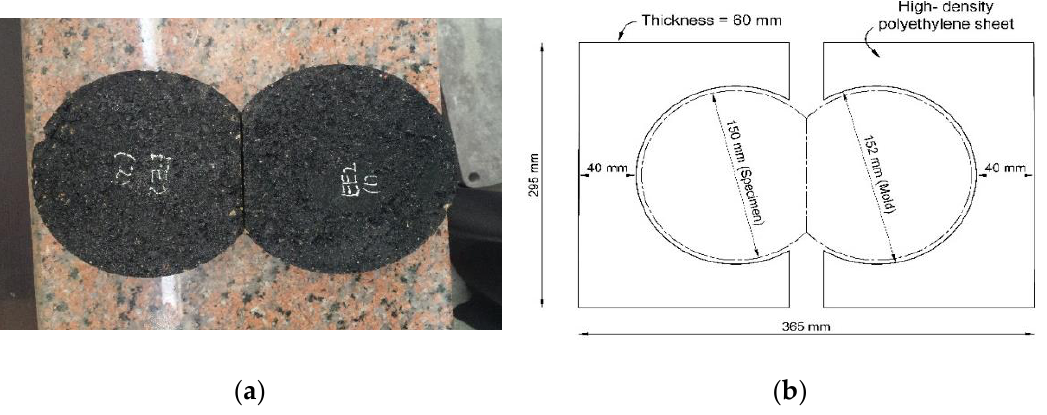
Figure 7. ( a ) Cut edge samples, ( b ) high-density polyethene mold.